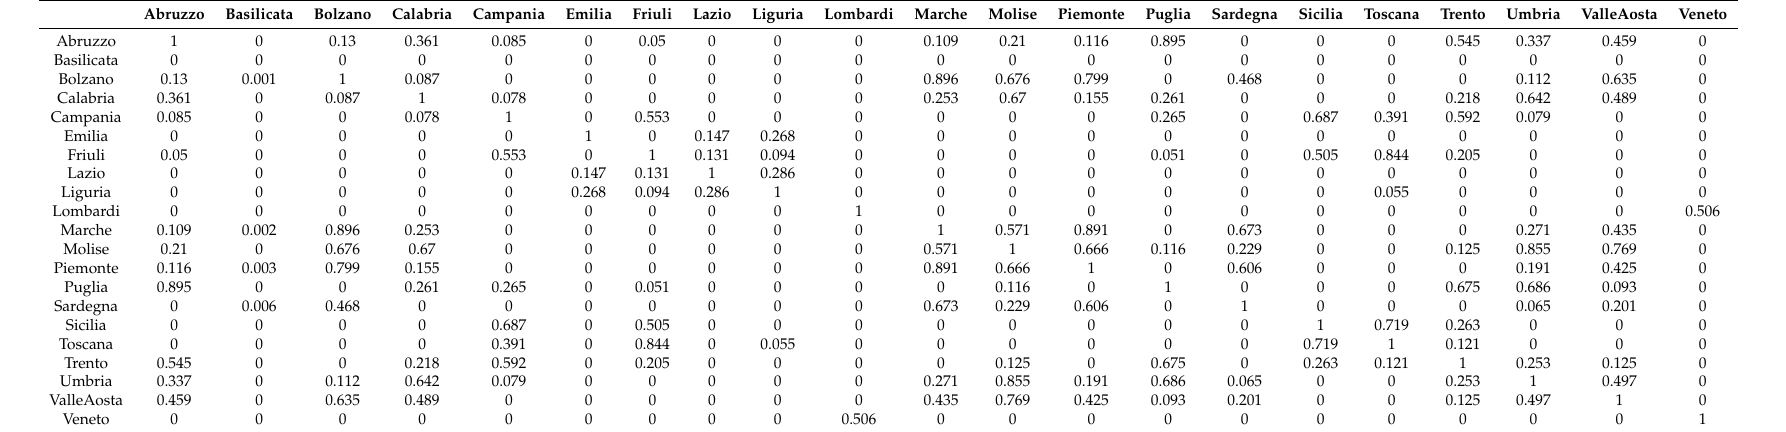
Table A37. Similarity values of Discharged/Healed network in the study period.